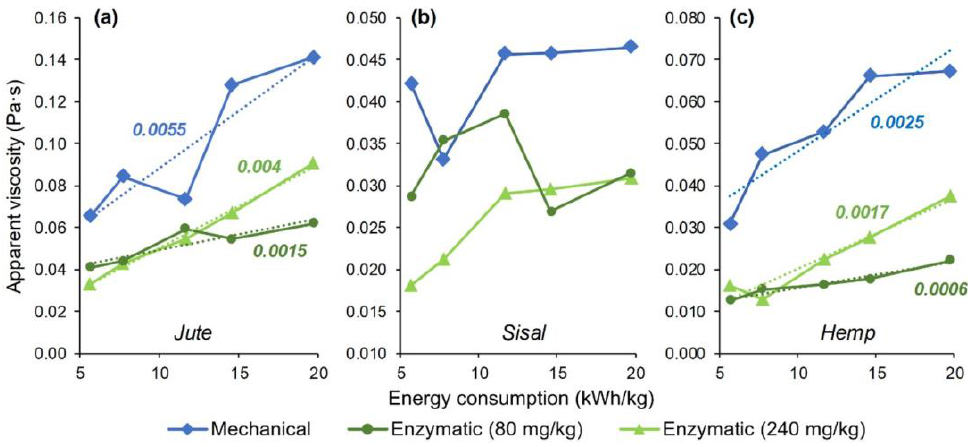
Figure 6. Evolution of the apparent viscosity at 100 s − 1 of suspensions of MNFC from jute ( a ), sisal ( b ) and hemp ( c ). Numbers in italics represent the slope of a trend line.